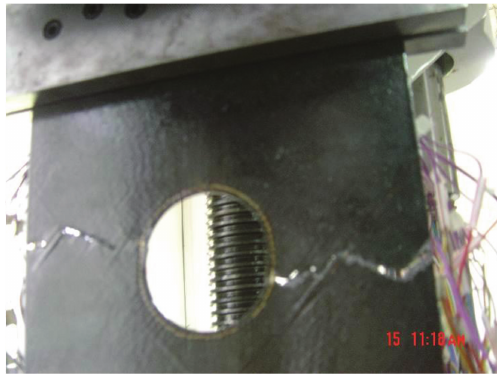
Figure 3: Experimental configuration. Figure 4: The damaged specimen.